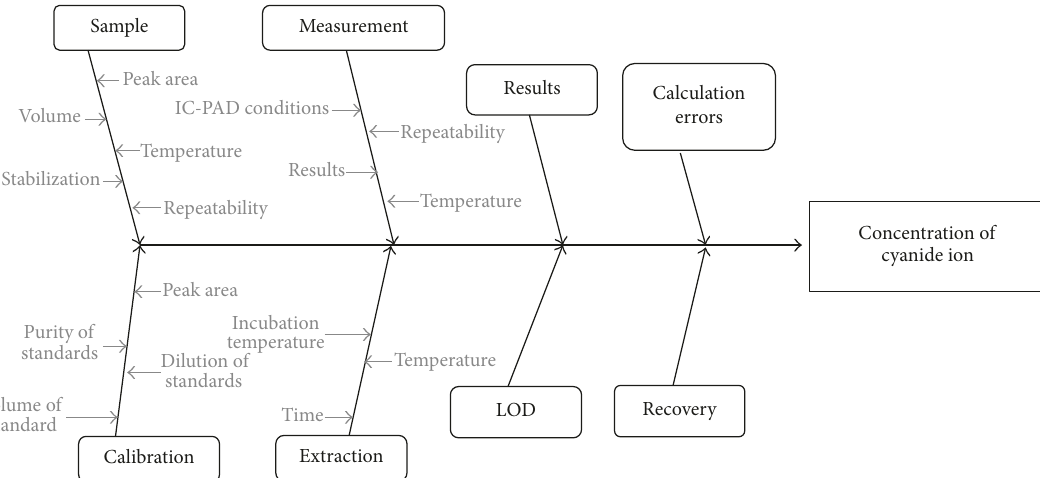
Figure 3: The Ishikawa diagram presenting the influence of parameters on the analytical process for the determination of cyanide ion in a biological sample.